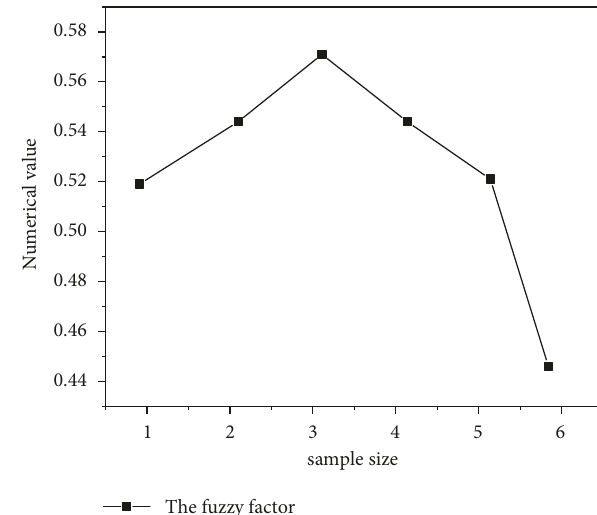
Figure 5: Similarity coefficient results of sample pixels.